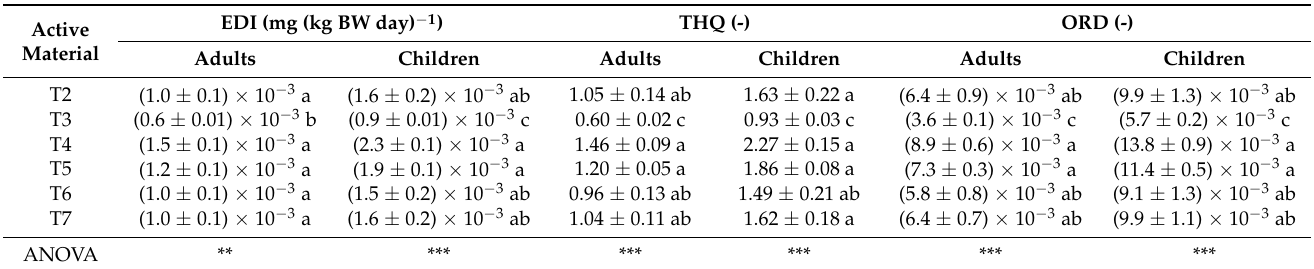
Table 5. Values of EDI (mg (kg BW day) − 1 ), THQ, and ORD indexes, according to the Cd con- centration in the inflorescence for plants grown in the presence of Cd with different treatments (T2: NS + Cd, T3: NS + Cd + BioG, T4: NS + Cd + Se1, T5: NS + Cd + Se2, T6: NS + Cd + chitosan1, and T7: NS + Cd +